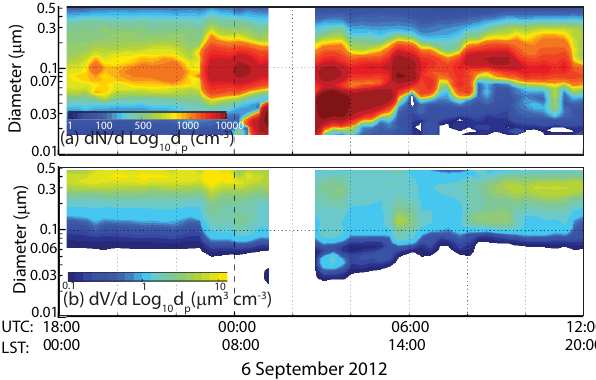
Figure 9. Electrostatic classifier particle number and volume dis- tribution for the 6 September nucleation event at Apo Reef. Cor- responding whole-air samples are listed in Table 1 including 22:20UTC 5 September as a pre-event can, 02:45UTC 6 Septem- ber in the middle of the event, and 07:30UTC 6 September for post-